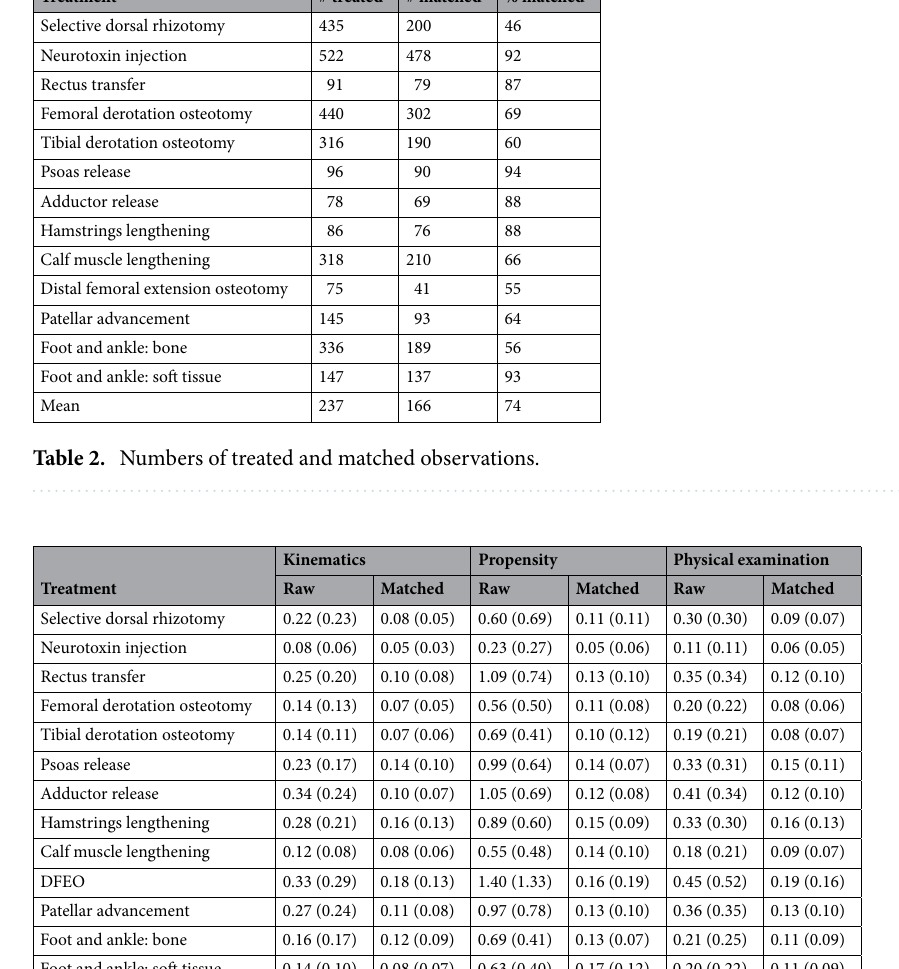
Table 3. Effect of matching on covariate balance (standardized mean difference). All values mean (SD).